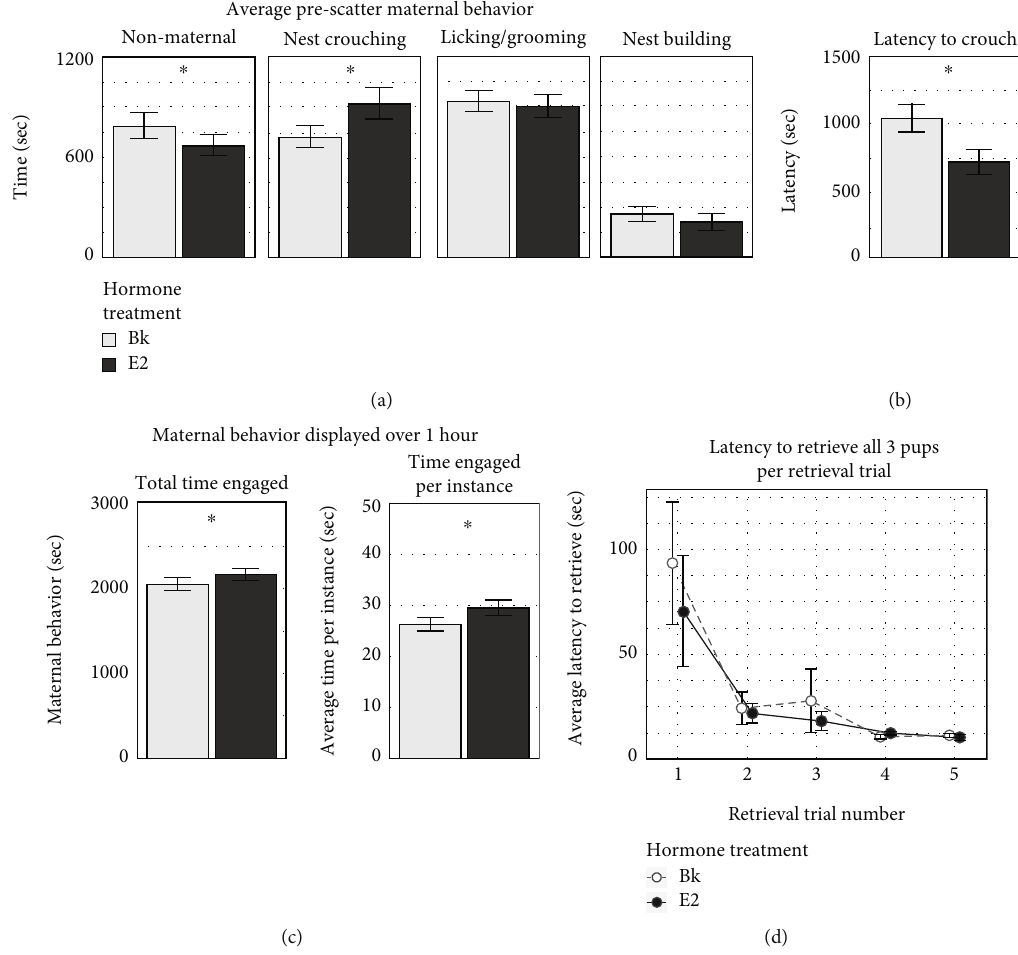
Figure 3: E2 a ff ected the amount of maternal behavior in seconds (sec) displayed by pup-exposed subjects (Px) over the course of 1 hr of pup experience but did not a ff ect pup retrieval behavior. (a) During the fi rst 45min of pup experience, the PxBk group showed more time engaged in nonmaternal behaviors than the PxE2 group ( p = 0 : 02 ). The PxE2 group spent more time engaged in nest crouching